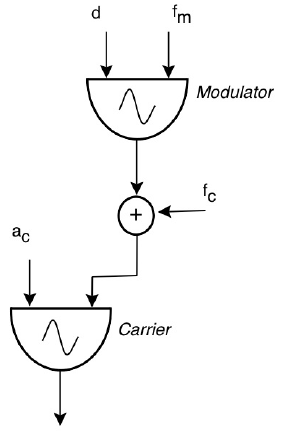
Figure 5. A simple FM synthesis scheme with two oscillators: a modulator and a carrier. Whereas d defines the amplitude and f m the frequency of the modulator, respectively, a c defines the amplitude of the carrier. The sinusoidal output from the modulator is added to the frequency of the carrier ( f c ). The Q1Synth implementation of FM requires values for seven